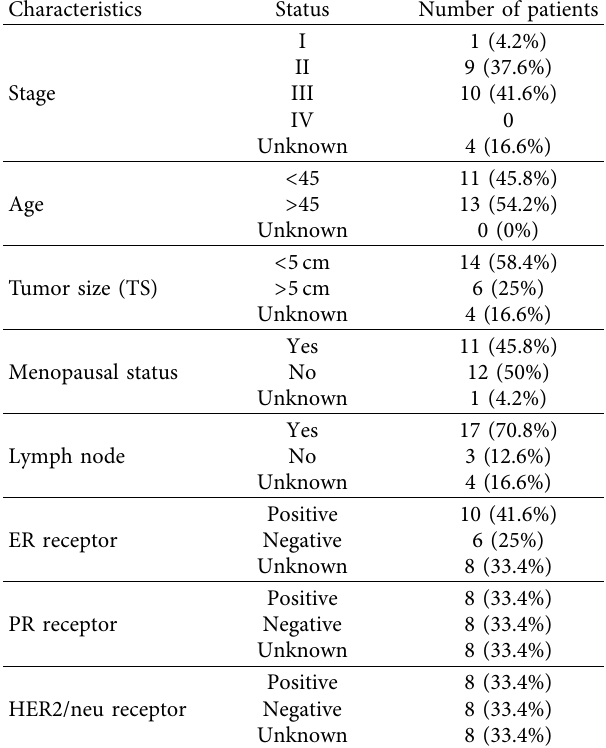
Table 2: Primers for real-time PCR analysis. Table 1: The pathological characteristics of patients.